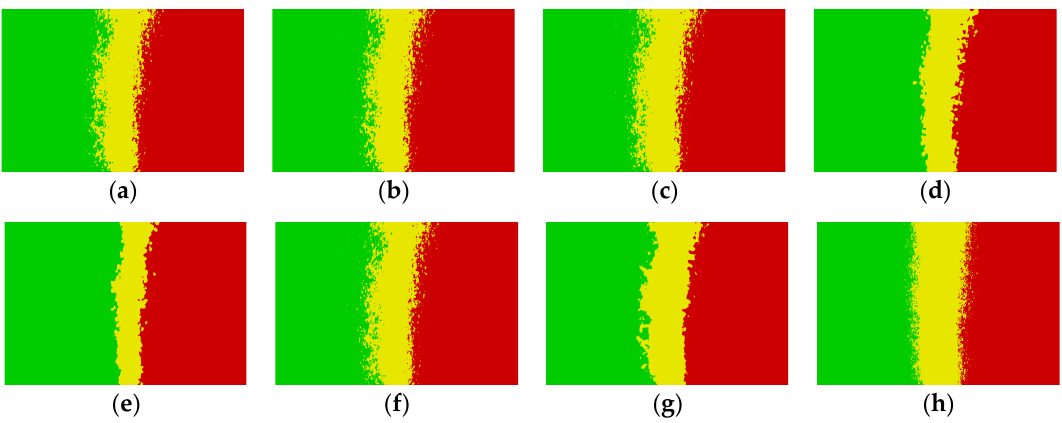
Figure 12. Segmentation results on the first aliasing image which roughness is 0.0392 μm . ( a ) FCM_S1